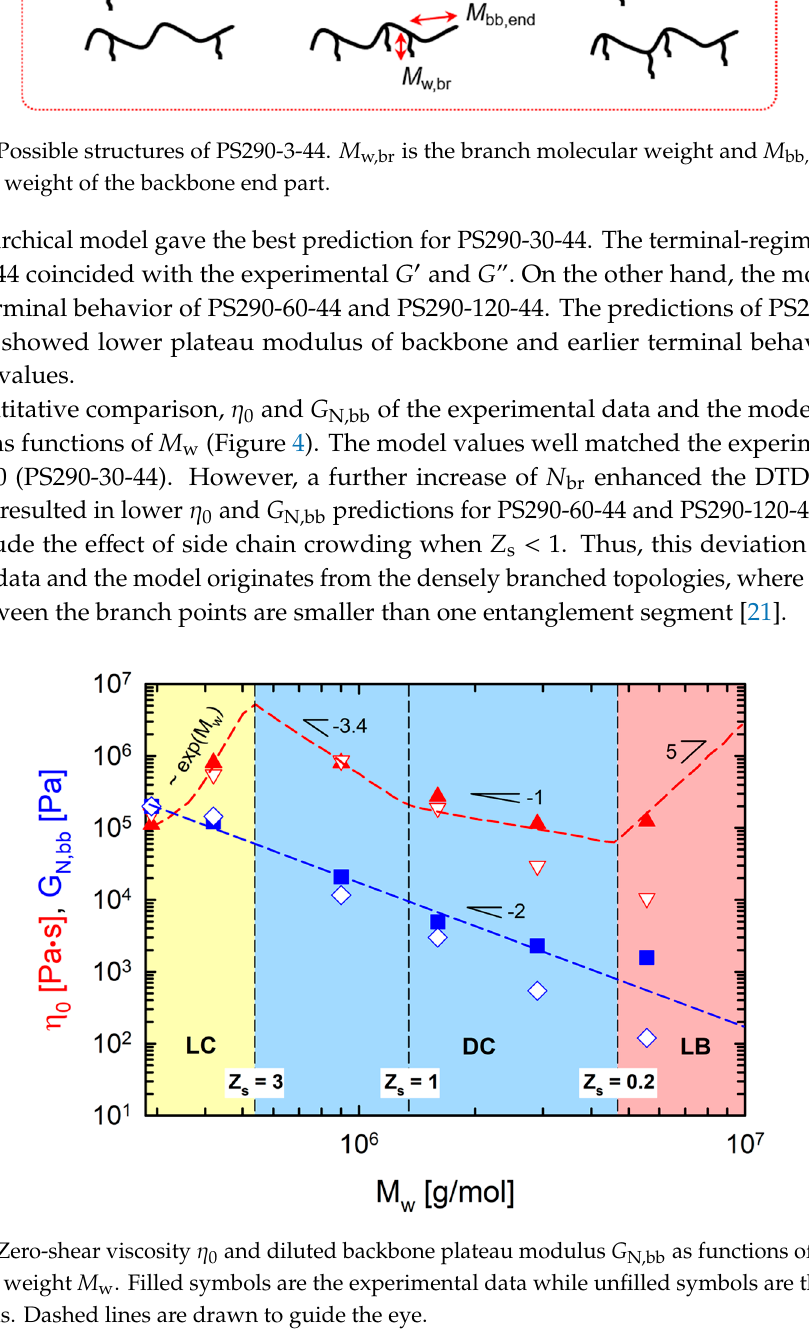
Figure 2. Comparison between experimental data and the hierarchical model predictions. ( a ) PS290, PS44 ( b ) PS290-3-44, ( c ) PS290-14-44, ( d ) PS290-30-44, ( e ) PS290-60-44 and ( f ) PS290-120-44. The symbols indicate experimental data of the model comb PS. The lines indicate the predictions of the hierarchical model.